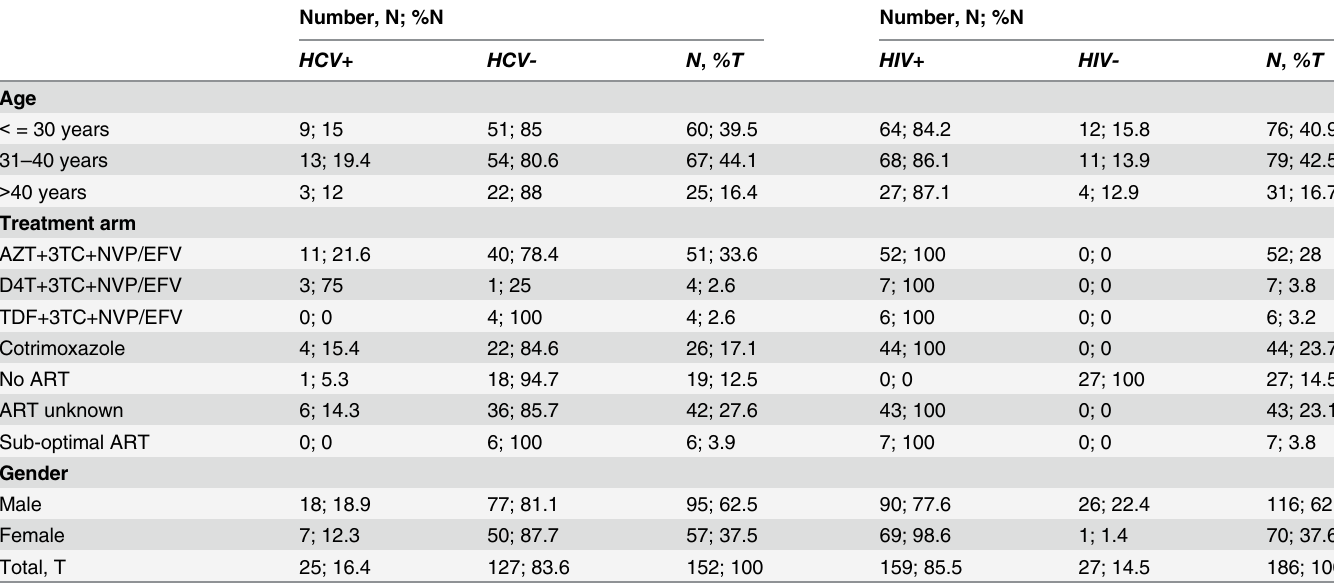
Table 1. Baseline demographic and infection characteristics of